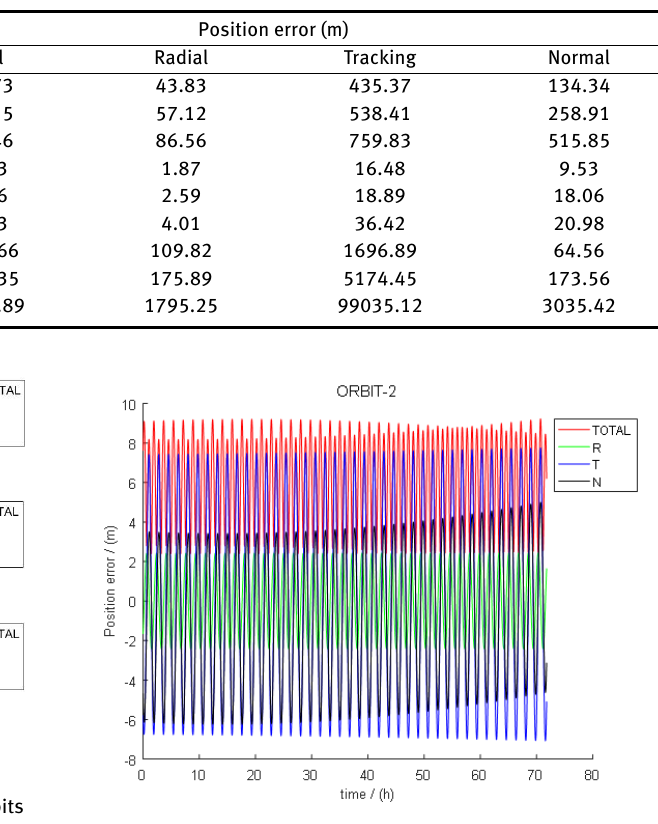
Figure 8. Position error of ORB-2 determined using 3 days of ground- based radar data, assuming no errors in dynamic